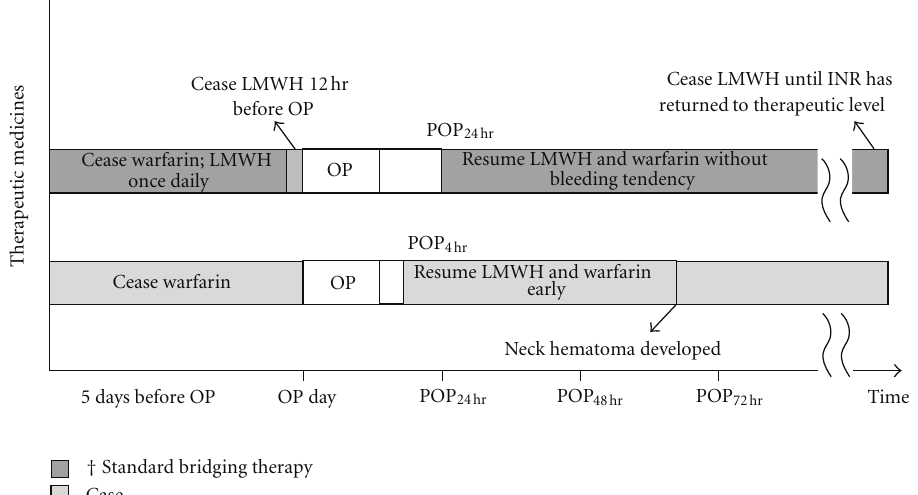
Figure 1: Protocol of standard bridging therapy and medications in patients with low thromboembolism risk/high bleeding risk. LMWH is continued until the INR has returned to the therapeutic level. LMWH: low molecular weight heparin; OP: operation; POP: postoperatively; INR: international normalized ratio.